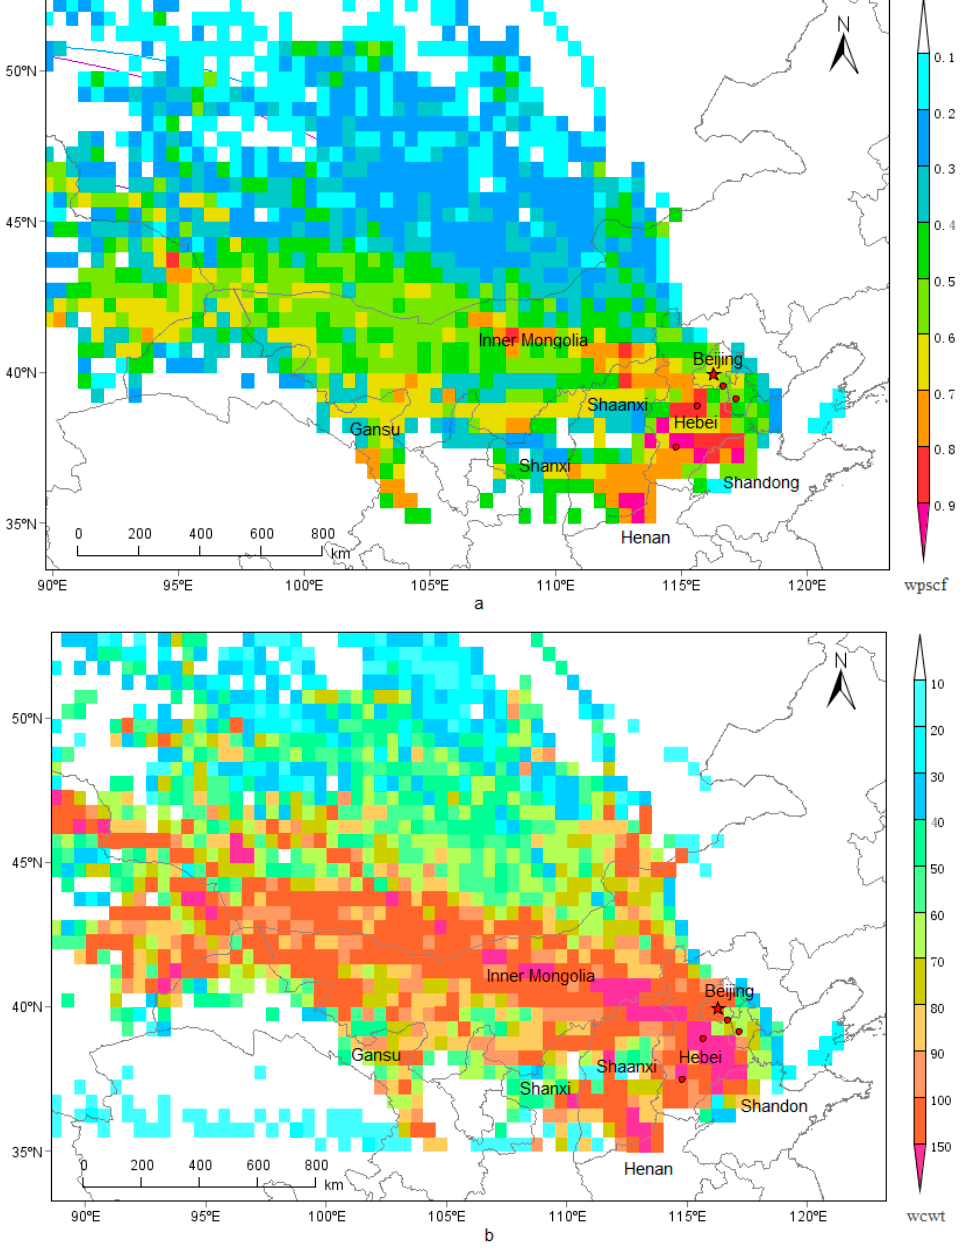
Figure 7. Potential Source Contribution Function (PSCF) ( a ) and Concentration Weighted Trajectory (CWT) ( b ) analysis based on the concentration of PM 2.5 .